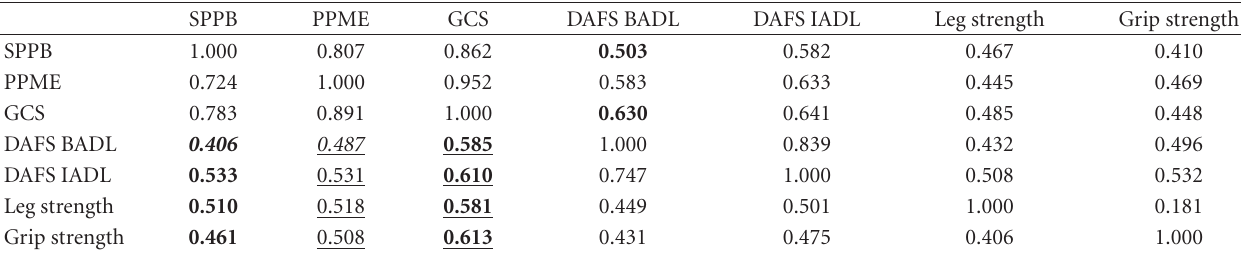
Table 2: Intercorrelations among performance measures and criterion variables for Centenarians (below diagonal) and Octogenarians (above diagonal).